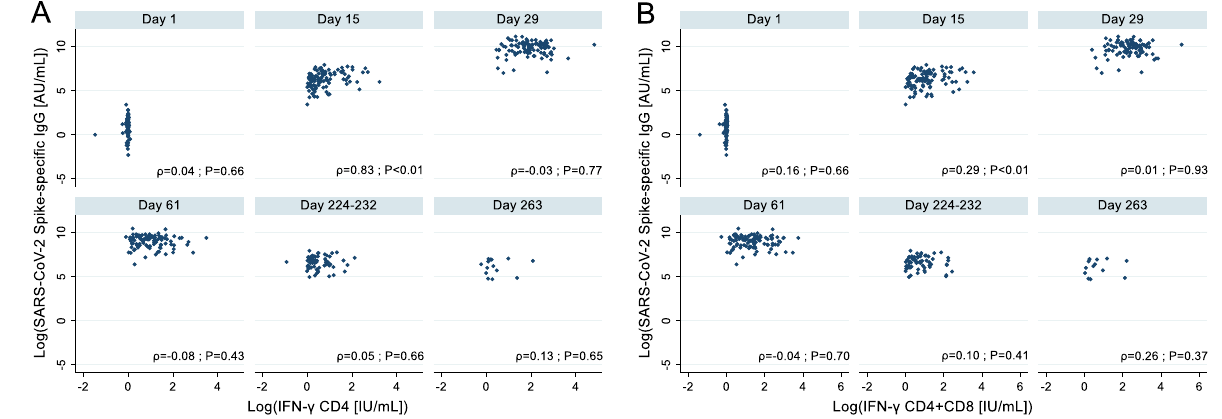
Figure 4. Correlation between SARS-CoV-2 spike specific IgG titers and T cell responses at each time point. Spearman’s rank correlation test was conducted using STATA version 17.0. ( A ) Correlation between IgG-S-RBD titer and spike-specific CD4 + T-cell responses. ( B ) Correlation between IgG-S-RBD titer and spike-specific CD4 + and CD8 + T cell responses. The correlation was assessed at each time point: day 1 (immediately after the first dose) (n = 100), day 15 (n = 100), day 29 (7 days after the second dose) (n = 97), day 61 (n = 97), day 224–232 (n = 66), and day 263 (n =